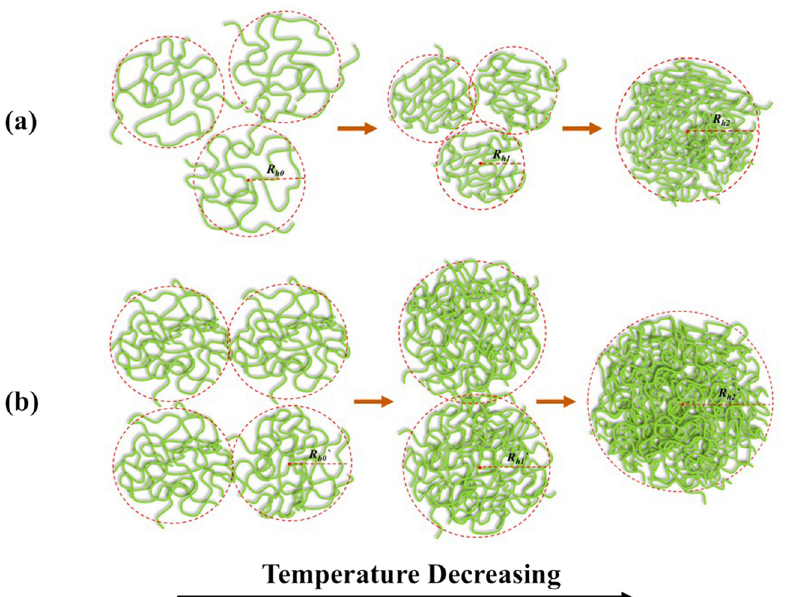
Figure 8: The schematic of the movement of PAN coils in solution: ( a ) without water and ( b ) with 10% water during the cooling